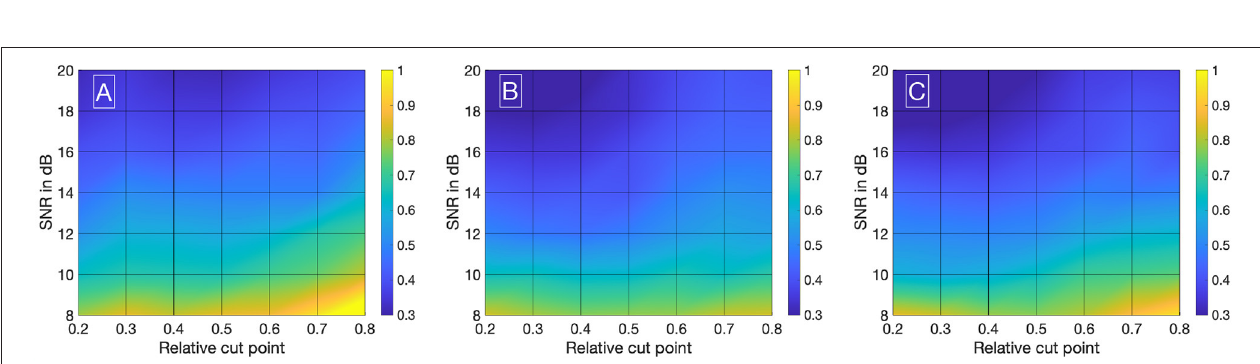
25 Hz ). Before fitting the model, cut method 3 is applied to the data set. To